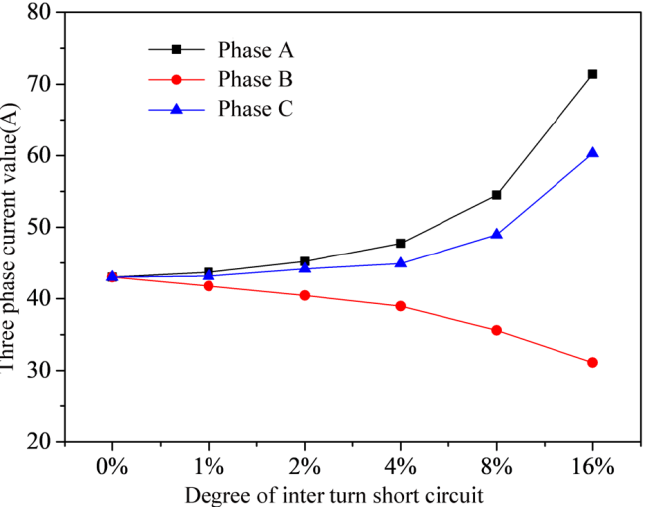
Figure 4. Trend of three − phase current.